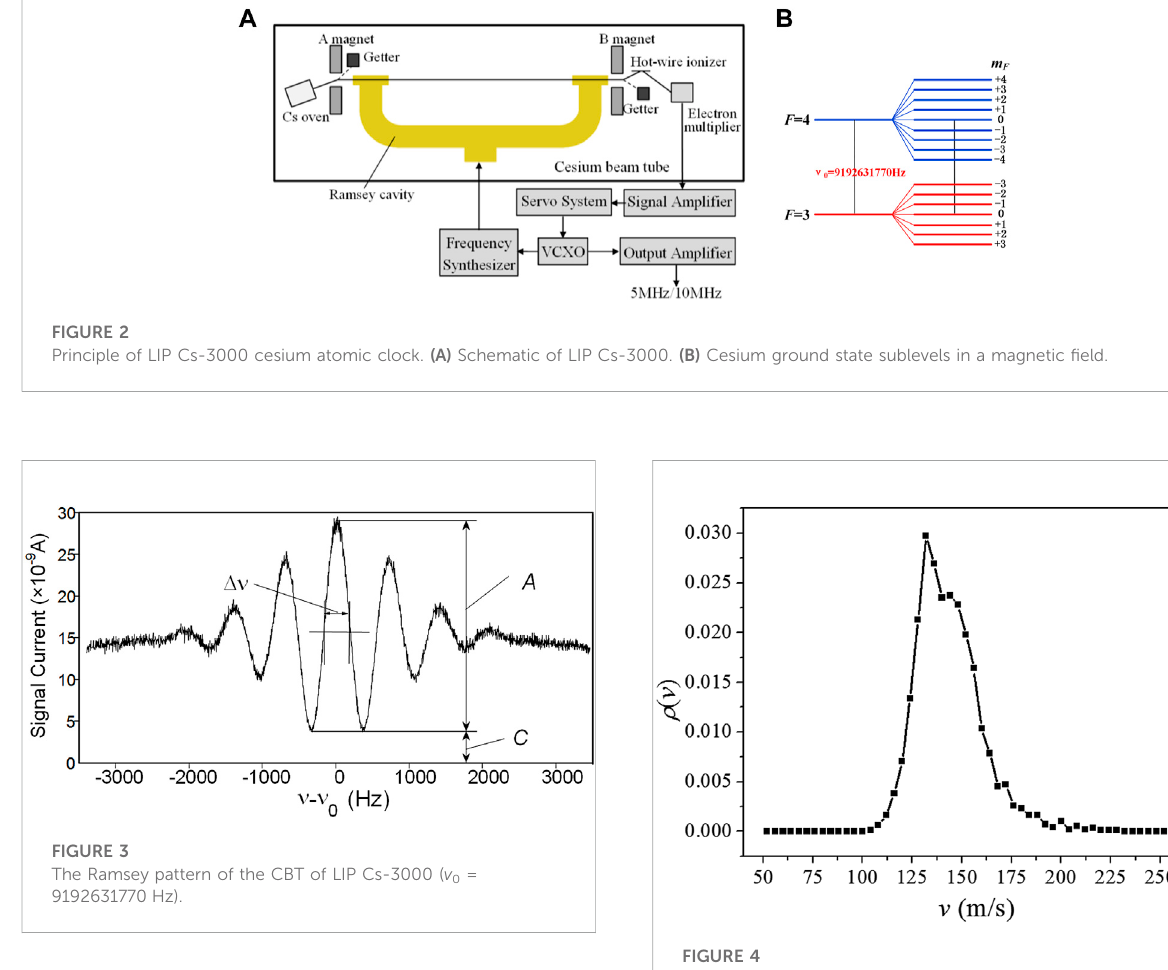
FIGURE 4 Velocity distribution of the signal atoms in CBT of LIP Cs- 3000 clock.